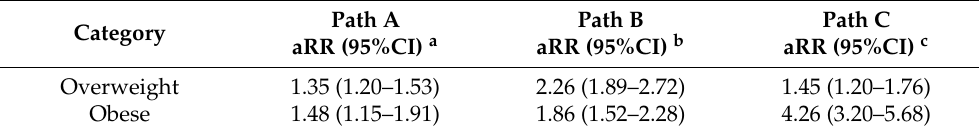
Table 3. Testing for significance of Path A, B, and C.